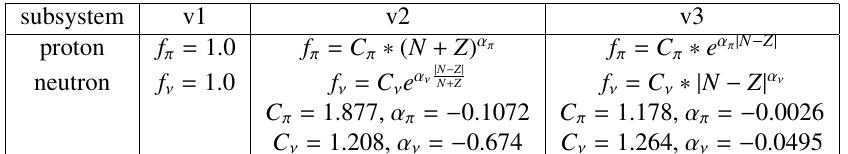
Table 1. Di ff erent versions (v1, v2 and v3) of separable pairing interaction as defined by the particle number dependencies of their scaling factors f i ( i = π or ν ). The constants C i and α i are taken from Table 4 of Ref.